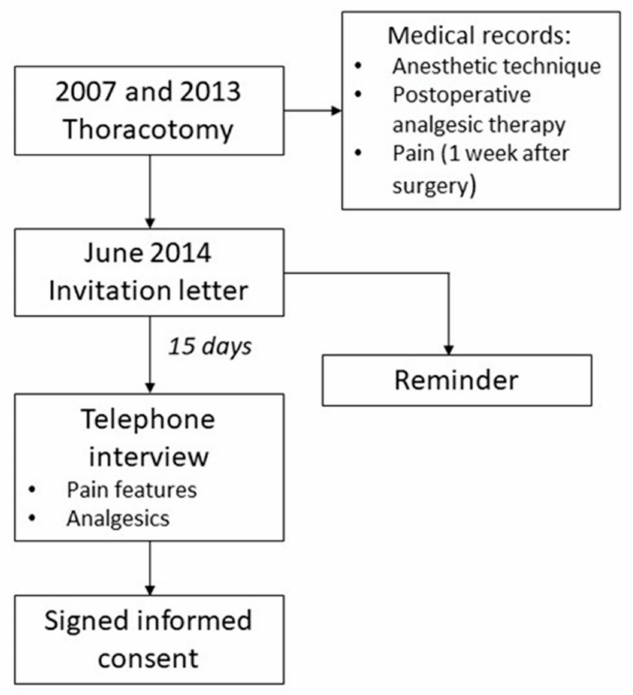
Figure 1. Flow-chart of the